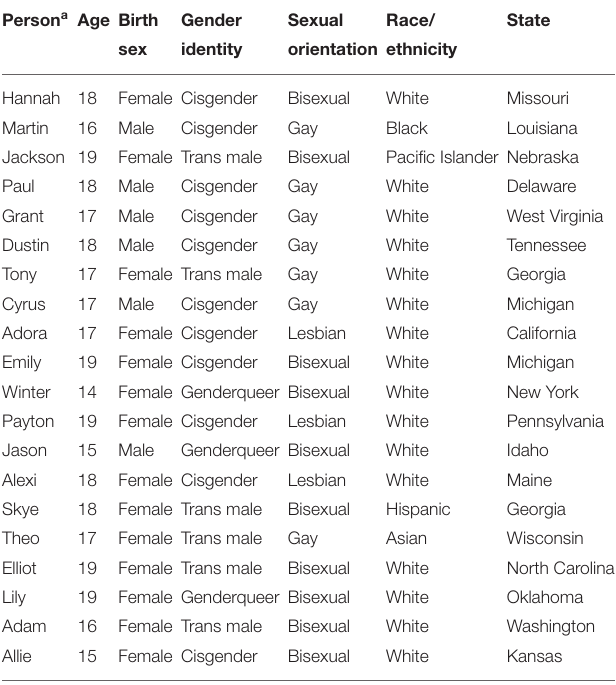
TABLE 1 | Demographic characteristics of rural sexual and gender minority youth participants. Person a Age Birth